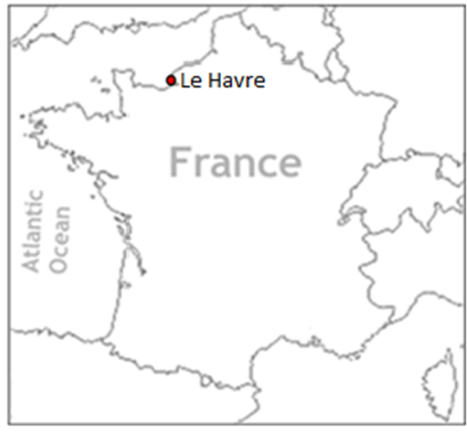
Figure 3. Case study (Le Havre): location